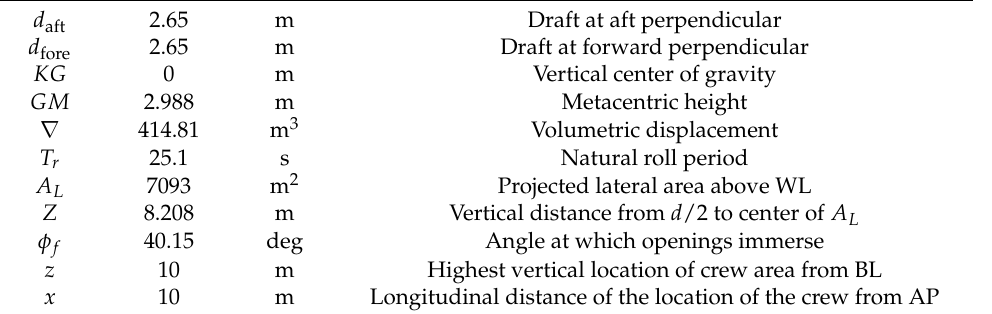
Table 37. Loading conditions of fishing